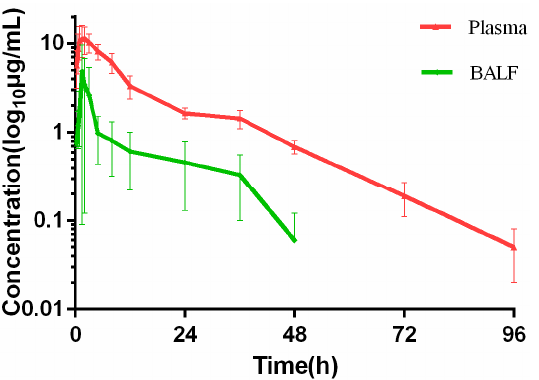
Figure 3. Time-concentration of DFC in plasma and BALF at different time points. Figure 3. Time ‐ concentration of DFC in plasma and BALF at different time points. Table 2. The pharmacokinetic parameters of CEF in infected pigs by I.M. at 5 mg/kg · bw. Parameter